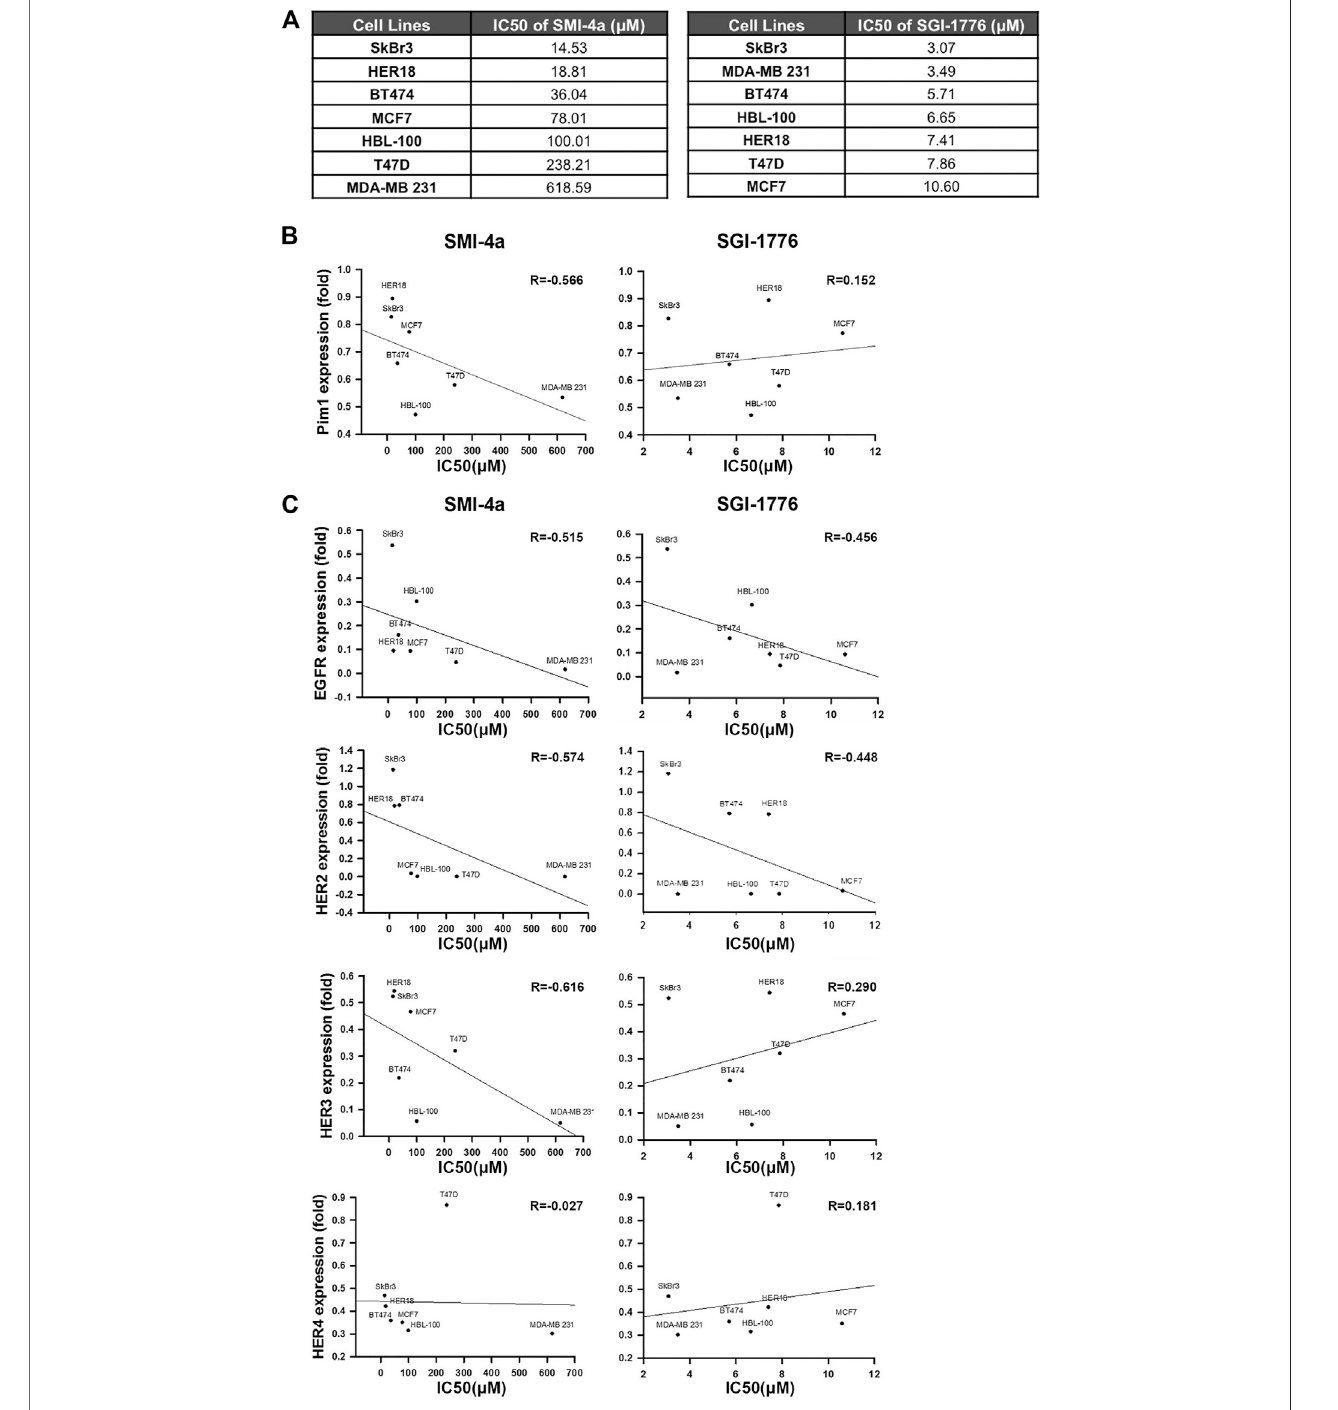
FIGURE2| HER2expressionwasstronglyassociatedwiththesensitivityofbreastcancercellstoPim1inhibitors .(A) ThesummarytableofIC50ofPim1inhibitors in various breast cancer cell lines. (B,C) The half-maximal inhibitory concentration (IC50) of Pim1 inhibitors, including SMI-4a and SGI-1776 in SkBr3, BT474, HER18, MCF7,T47D,HBL-100,andMDA-MB-231cells,wasdeterminedbyMTTassays.ThecorrelationsofIC50ofSMI-4aandSGI-1776withPim1 (B) ,EGFR (C) ,HER2 (C) , HER3 (C) and HER4 (C) expressions were determined by regression analysis.